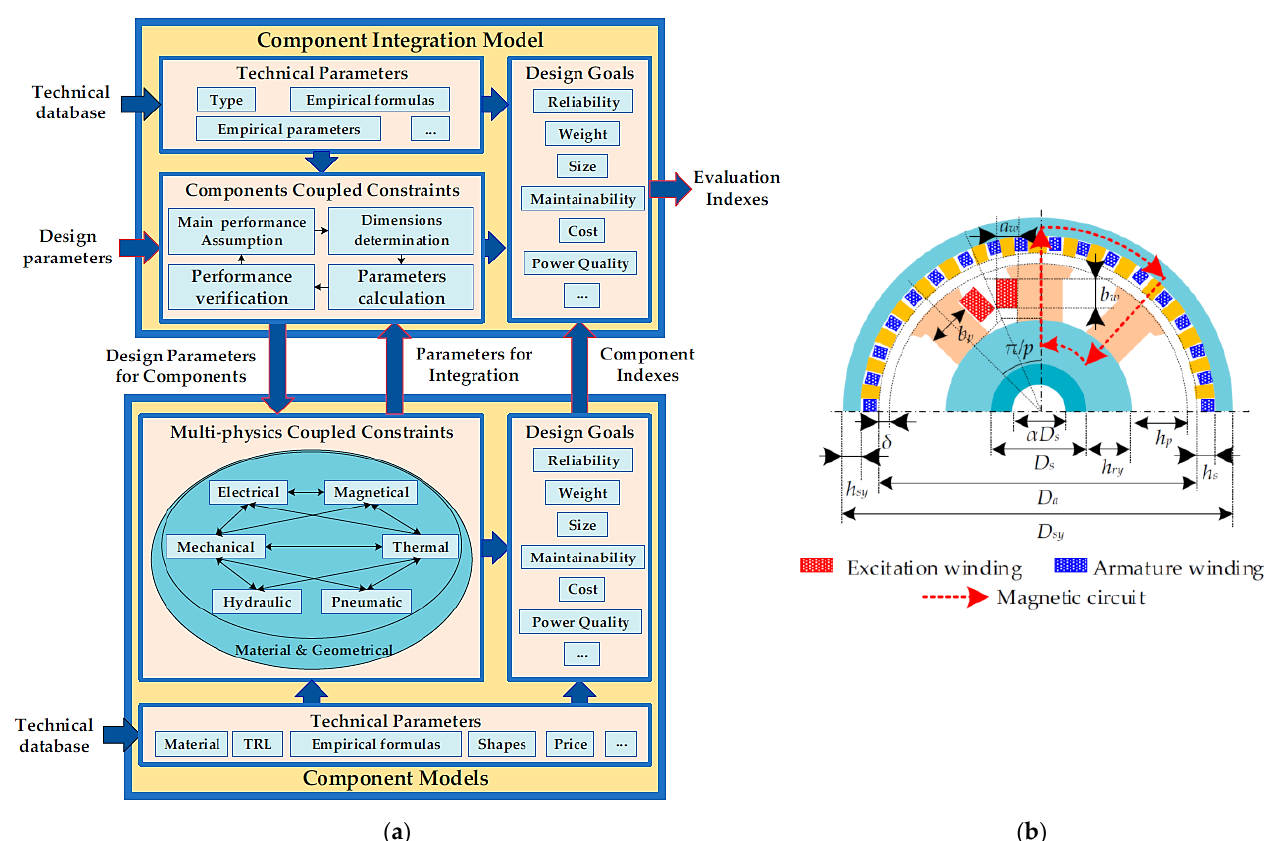
Figure 3. ( a ) The MDO methodology and the relation between its component models in the electrical machine and its integration into a system-level design process. ( b ) Salient pole synchronous generator [11].